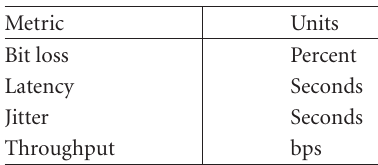
Figure 4: Experimental layout in OPNET. Table 3: The set of